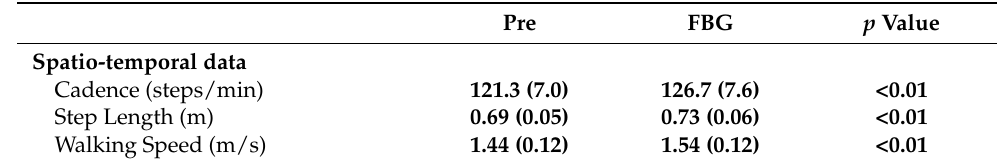
Table 2. Spatio-temporal data during walking pre and post wearing of FBG. average (SD), paired t -test, p values < 0.05 are bolded.